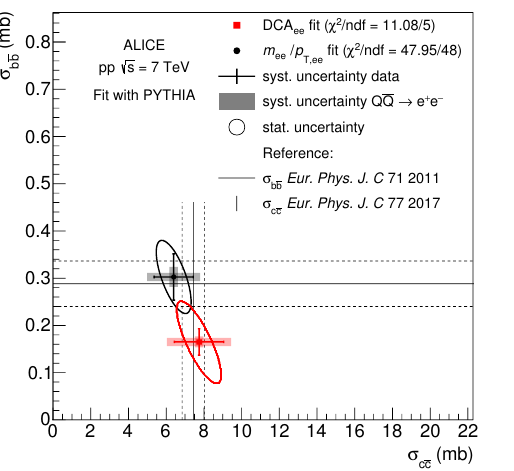
Figure 15 . (Colour online) Total cc and bb cross sections extracted from a (cid:12)t of the measured dielectron yield from heavy-(cid:13)avour hadron decays in ( m ee , p T ; ee ) and in DCA ee with PYTHIA (left) and POWHEG (right). The results and their uncertainties (see text) are compared to published cross sections, for which the total uncertainty is represented by dashed